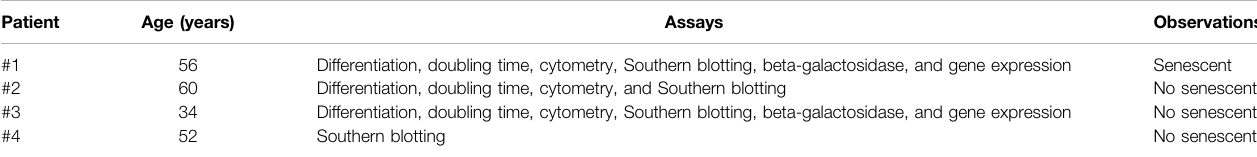
TABLE 1 | Patients ’ cells used in different assays in the